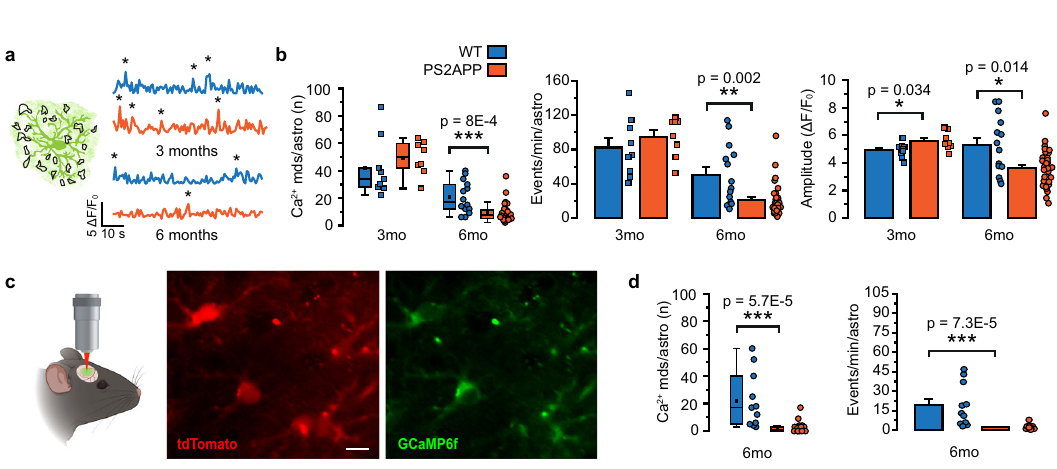
Fig. 2 | Spontaneous astrocyte Ca 2+ activity in SSCx brain slices and in vivo. a Spontaneous astrocyte activity at Ca 2+ mds, representative traces from 3mo and 6mo WT (blue) and PS2APP (orange) SSCx brain slices. Asterisks mark real Ca 2+ events. b Left, box and scatter plots of the number of Ca 2+ mds. Box plots show mean, median, 25th and 75th percentile, outliers. Right, bar histograms (mean± SEM)and scatterplotsreporting the frequencyand theamplitudeofeventsinCa 2+ mds. 3mo: n =9 astrocytes from 5 WT and 8 astrocytes from 5 PS2APP mice, 6mo: n =14astrocytesfrom6WTand32astrocytesfrom7PS2APPmice.Forthenumber of events/min and for the amplitude, only astrocytes with at least one active Ca 2+